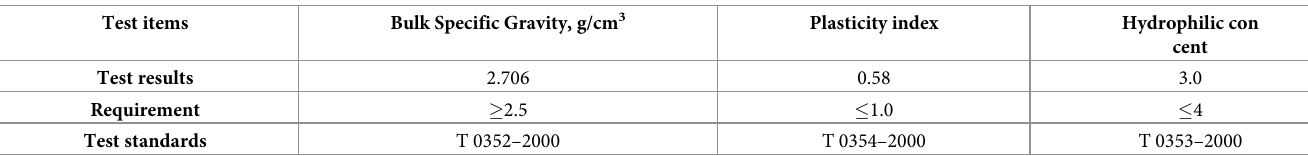
Table 4. Technical properties of mineral power.